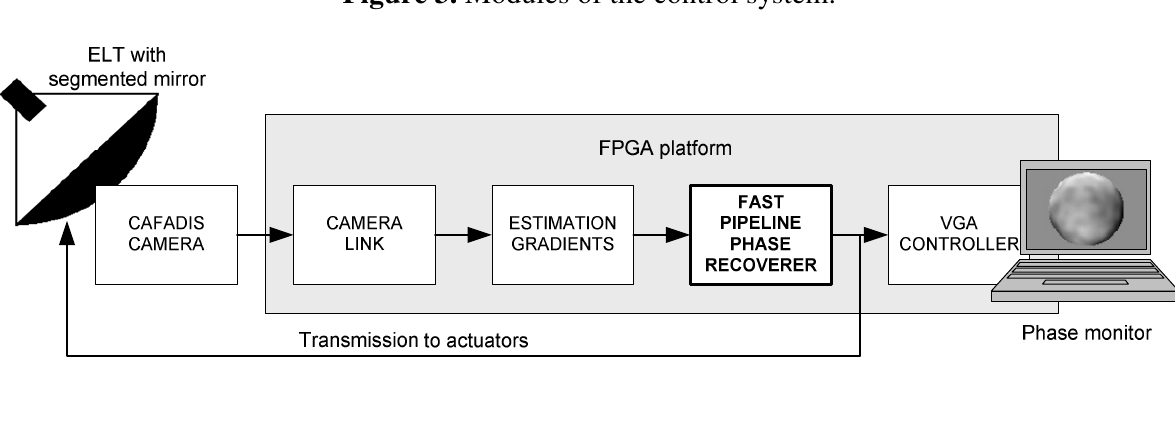
Figure 3. Modules of the control